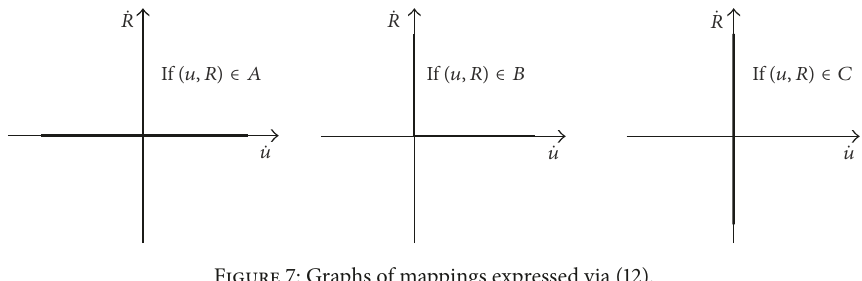
Figure 7: Graphs of mappings expressed via (12).